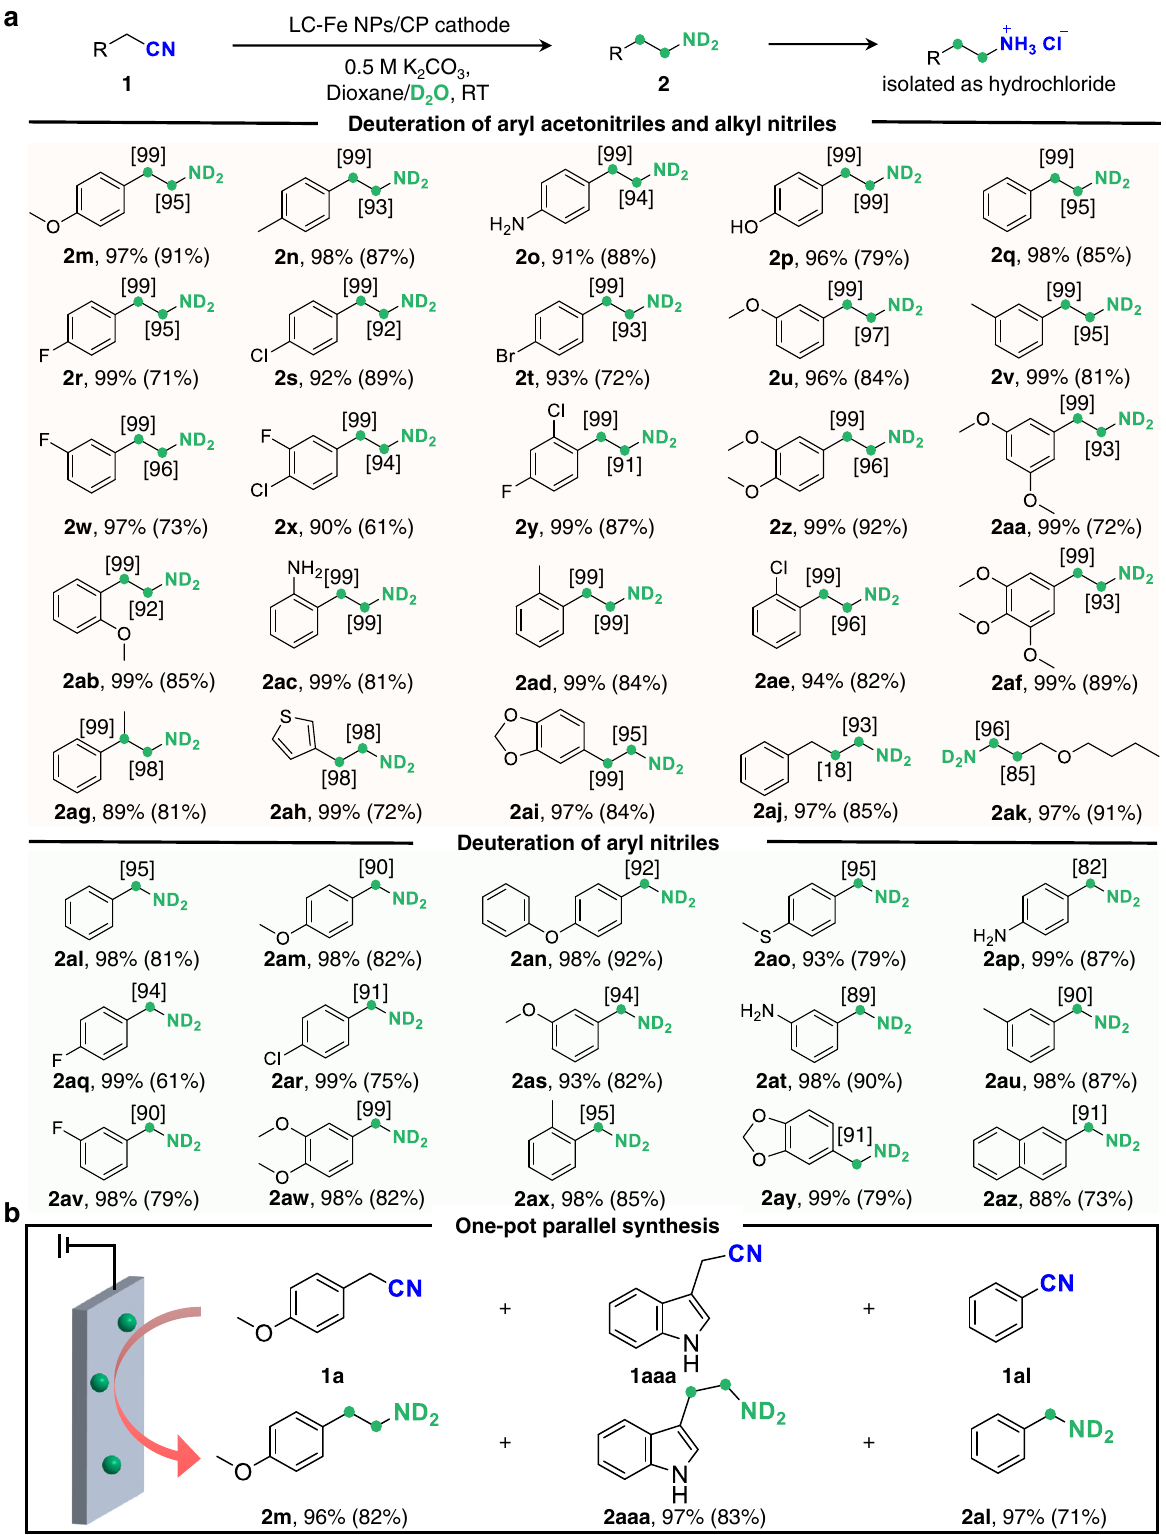
Fig. 5 | The universality of our electroreductive deuteration method. a α , β - DAEAsand α -deuteratedaminescontaining usefulfunctionalunitsaccessed byLC- Fe (isolated yields of the hydrochloride of primary amines are reported in the parentheses and deuterium ratios are presented in the brackets). Reaction condi- tions for the synthesis of α , β -DAEAs ( 2m - az ) from the corresponding aryl acet- onitriles:substrate(0.15mmol),inamixedsolutionof0.5MK 2 CO 3 inD 2 O/dioxane